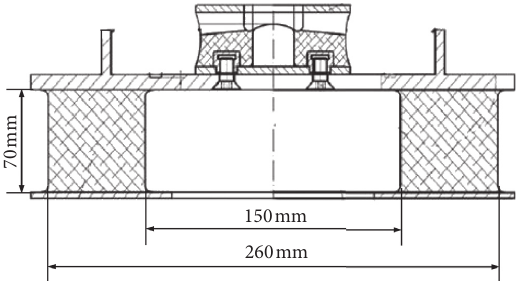
Figure 2: Rubber pad of China standard EMU.